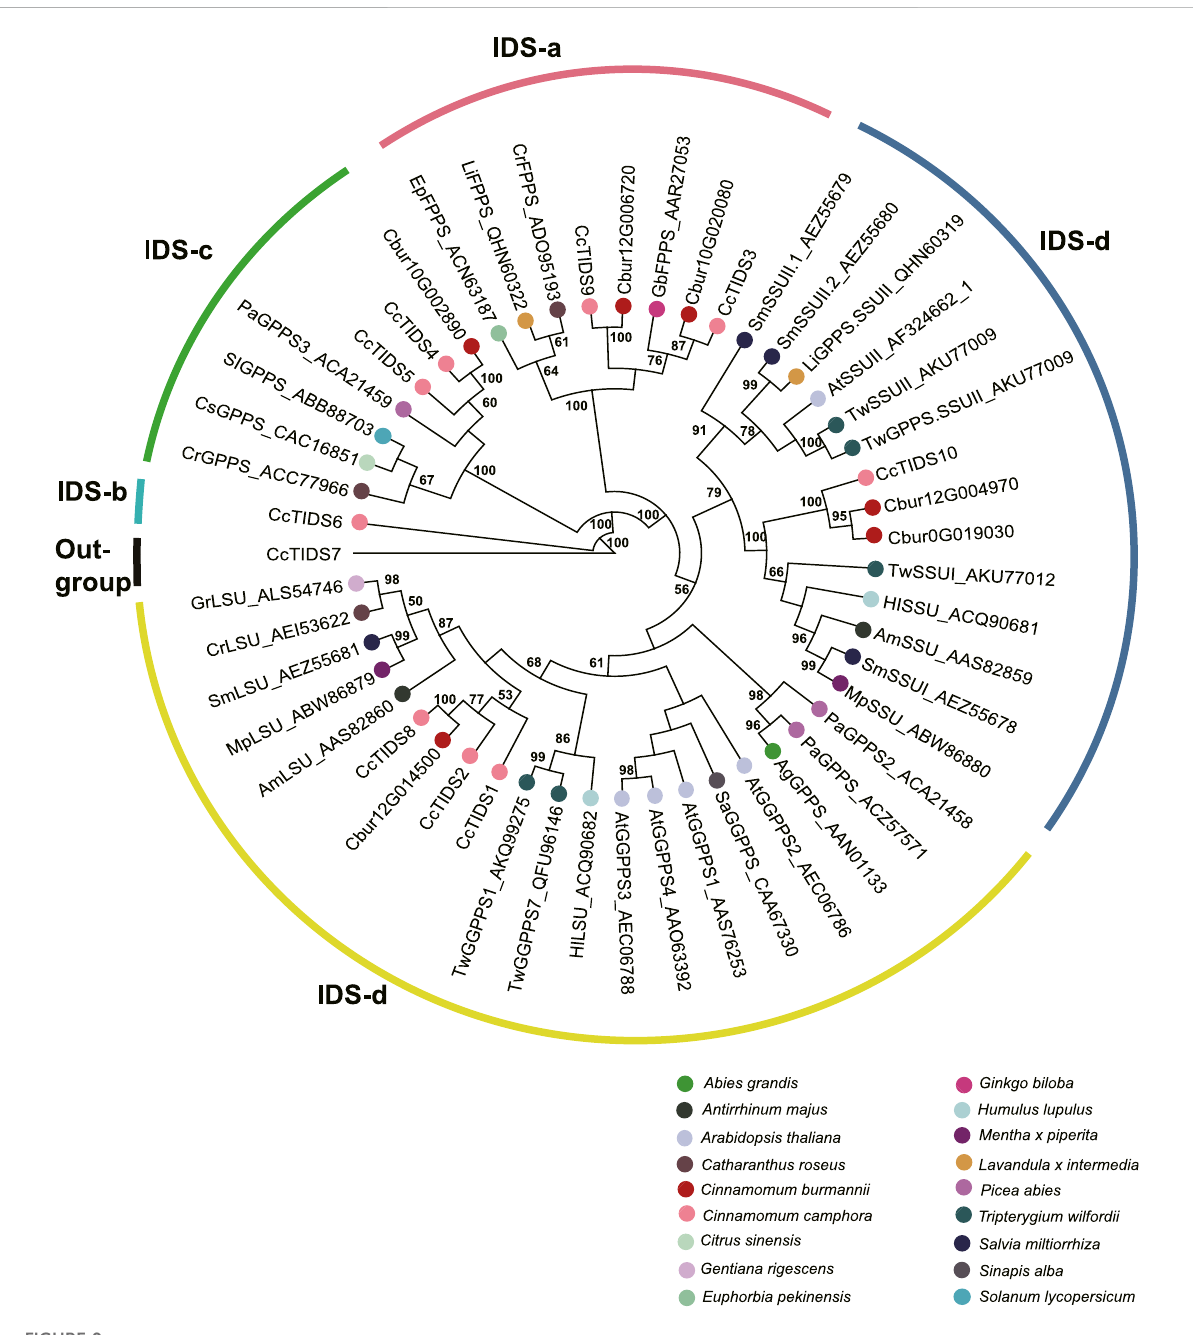
FIGURE 9 Phylogenetic relationship among the IDS genes of Cinnamomum burmannii established by the maximum likelihood method. Bootstrap values ≥ 50 are given at the nodes. The IDS genes of C. burmannii identi fi ed in the present study and other rereprentative IDS genes are indicated by the dots in different color. The accession information used for phylogenetic reconstruction is